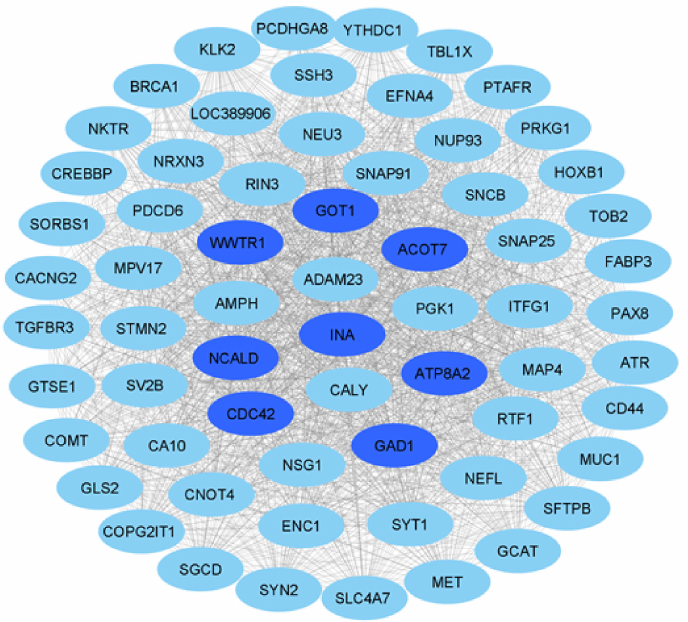
Figure 4. Co-expression network obtained with weighted correlation network analysis (WGCNA) and visualized with Cytoscape. Dark blue nodes correspond to the genes with a higher degree centrality. Grey colored edges indicate the gene